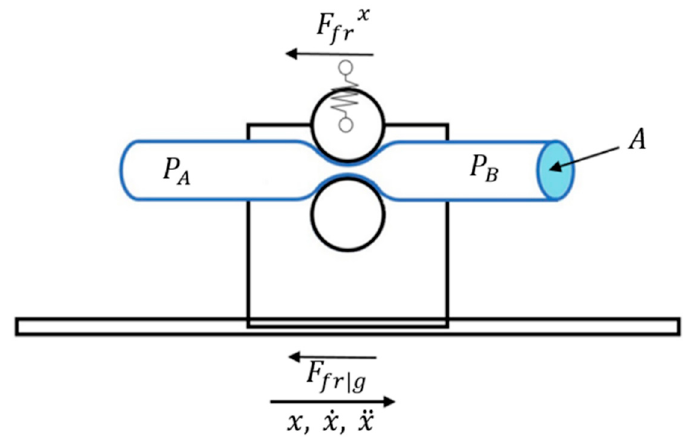
Figure 5. Mechanical model nomenclature.